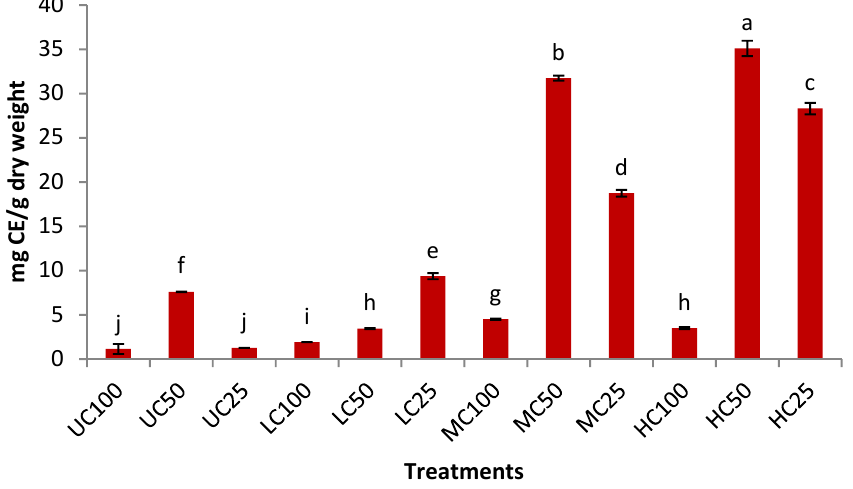
Figure 3. Total flavonoid content of air-fried eggplant. The treatment codes consisting of different letters and digits represent the uncooked (UC), high-cooked (HC), medium-cooked (MC), and low-cooked (LC) eggplant samples extracted with absolute ethanol (100), 50% ethanol (50), and 25% ethanol (25). The bars containing different letters are significantly different from each other ( p < 0.05). CE: catechin equivalent.